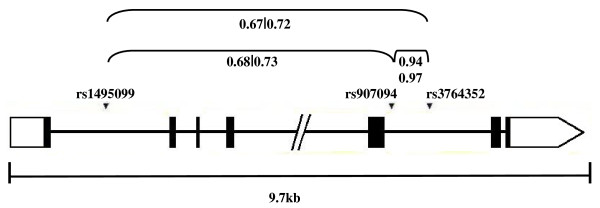
Illustration of the PPP1R1B locus. A schematic showing gene structure, marker positions and measures of linkage disequilibrium between rs1495099, rs907094 and rs3764352 listing r2 of the comparison group (N=435) followed by r2 of parents from families (N=216). Legend: ▪ exon; ━ intron; □ untranslated region.